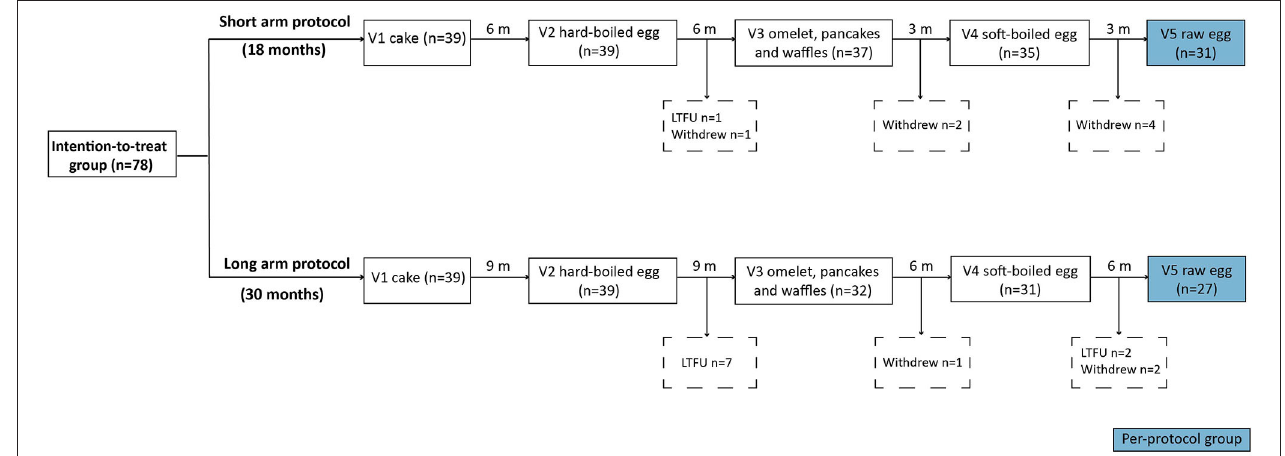
FIGURE 1 | Flow chart of the intention-to-treat group. V, visit; m, month; LTFU, lost to follow-up.